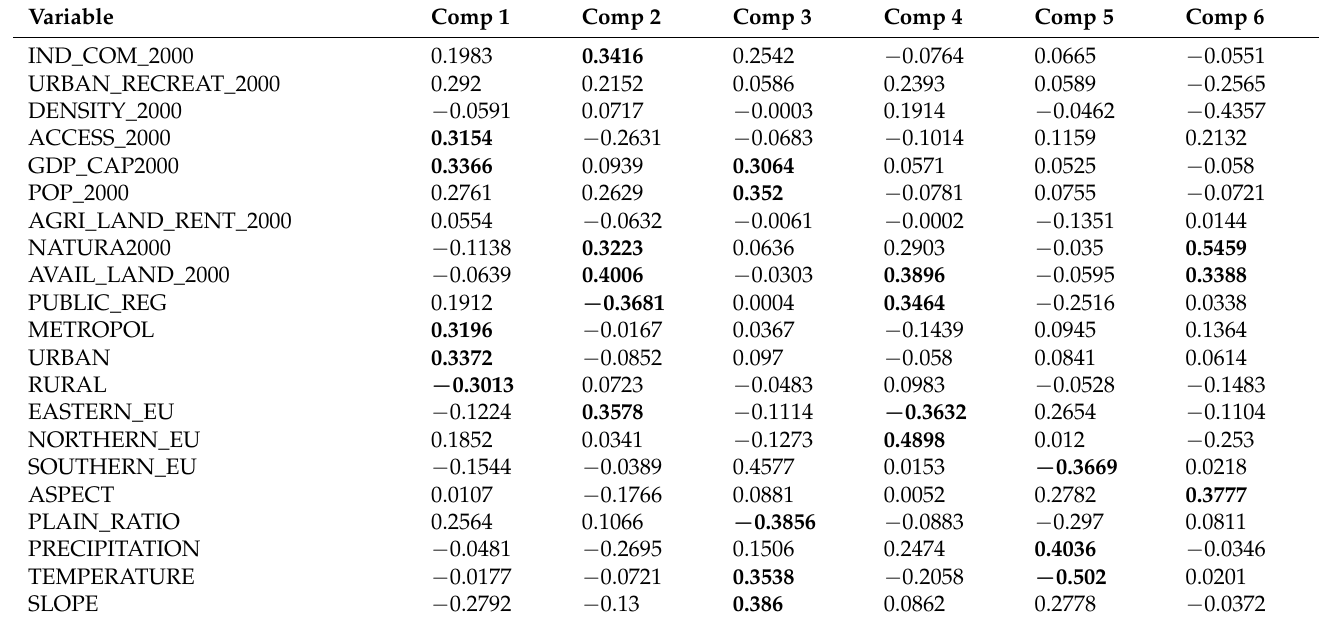
Table A2. Principal components (eigenvectors) for all the data covering the EU